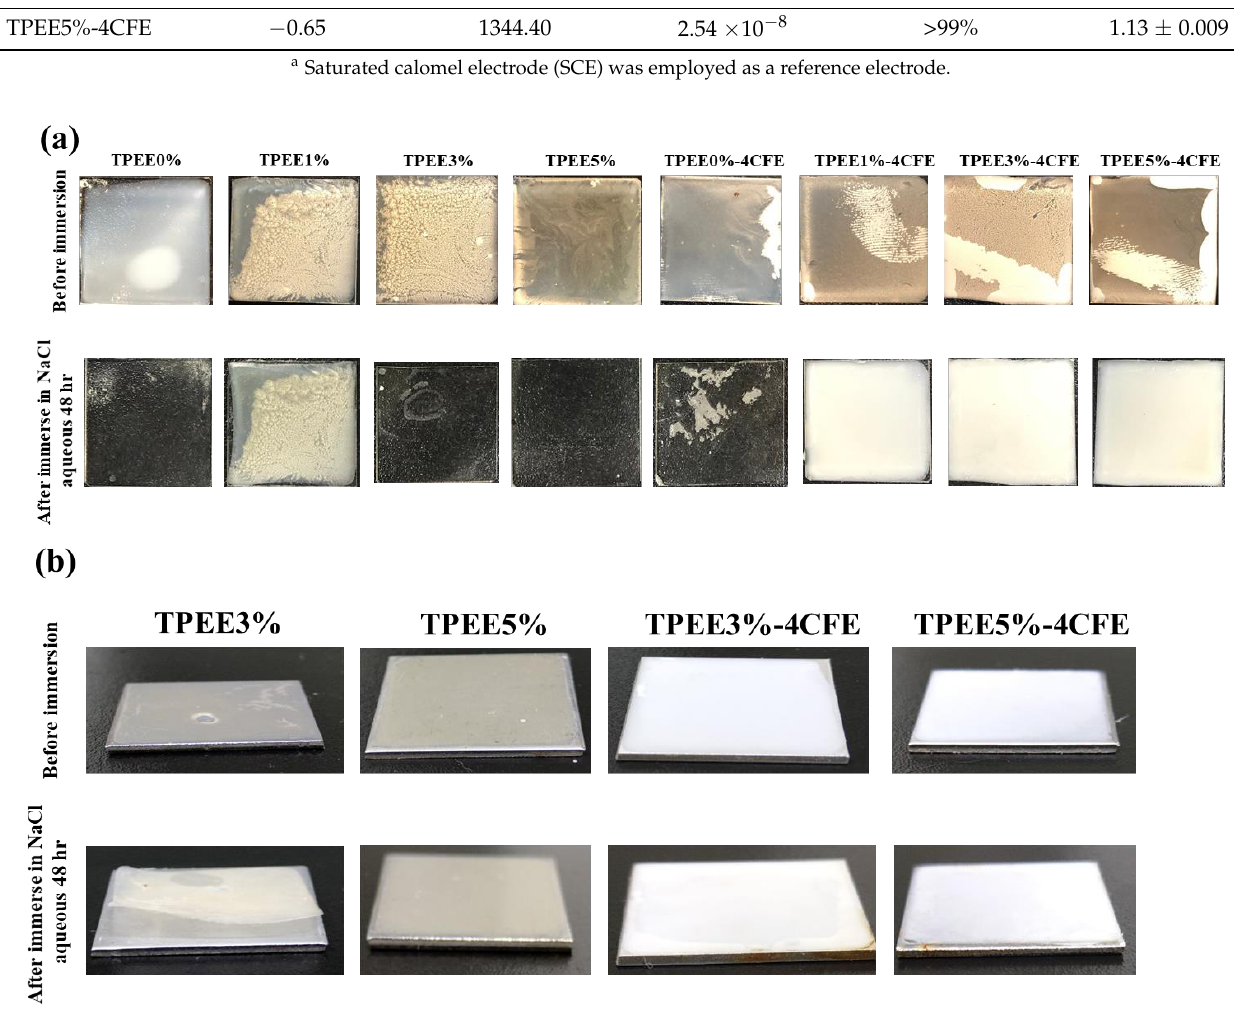
Figure 5. Adhesion testing of TPEEn% and TPEEn%-4CFE coated on ( a ) glass and ( b ) iron substrates and immersed in aqueous NaCl for 48 h.